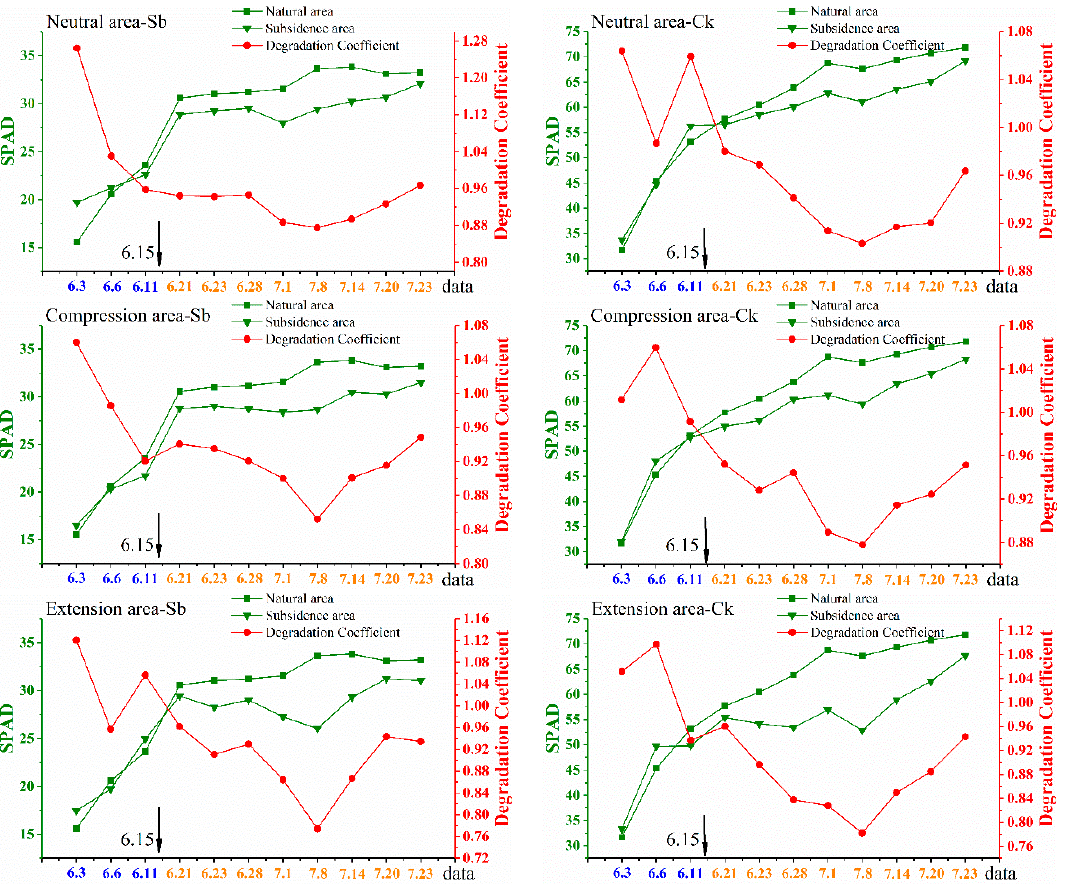
Figure 5. Time series monitoring results of chlorophyll content at leaf scale. All the data in the figures were obtained at transect 1. The 31,115 working faces were mined to the position of transect 1 on 15 June. There were two quadrants in each disturbance area, and only the data from the first quadrat are shown in the figures. Source: Built on the basis of the author’s field survey and